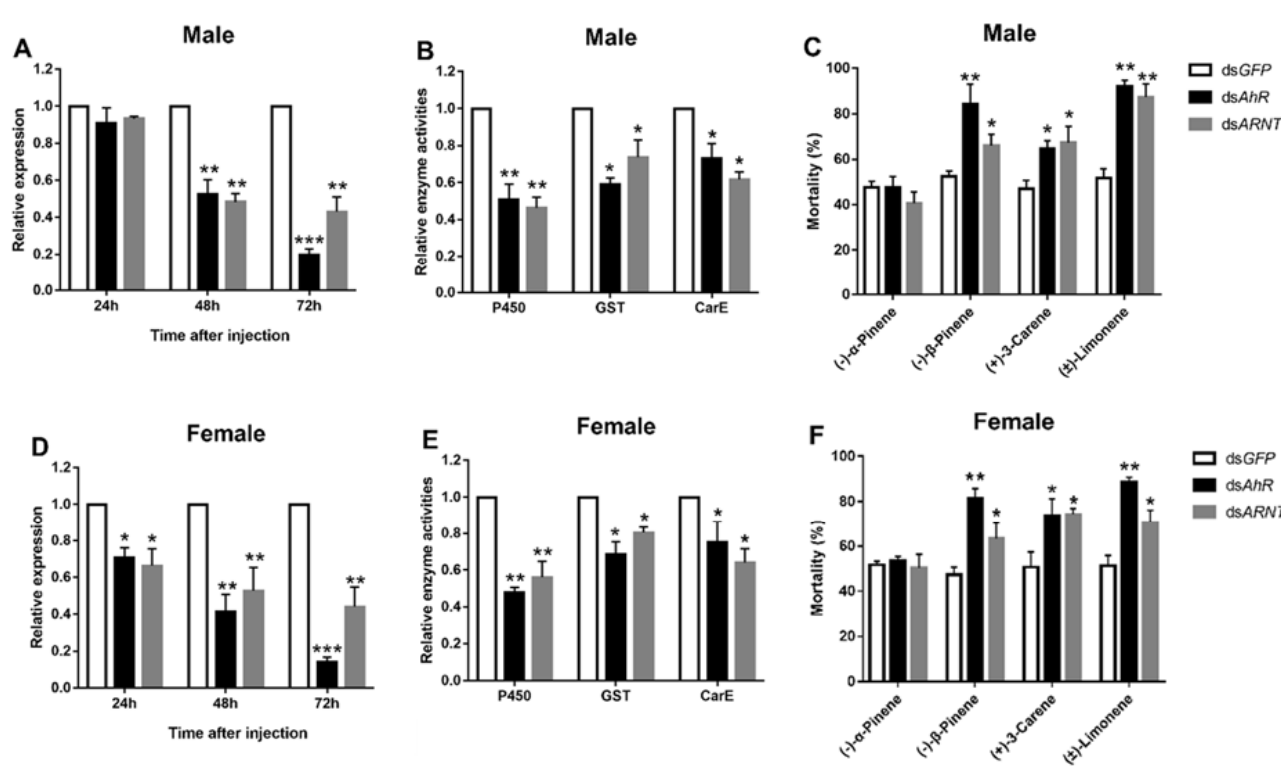
Figure 5. Functional analyses of AhR and ARNT by RNAi in D. armandi adults. ( A , D ) Relative expression levels of DaAhR and DaARNT in adults injected with dsRNA at 24, 48, and 72 h post- injection. ( B , E ) Relative detoxification enzyme activities after the silencing of DaAhR and DaARNT . ( C , F ) The mortality of adults exposed to four terpenoids was assessed at 48 h after dsRNA injection. The relative expression levels were normalized with β -actin and CYP4G55 . The asterisk indicates a significant difference between treatment groups (* p < 0.05, ** p < 0.01, *** p < 0.001, independent Student’s Test). All values are mean ± SE , n =